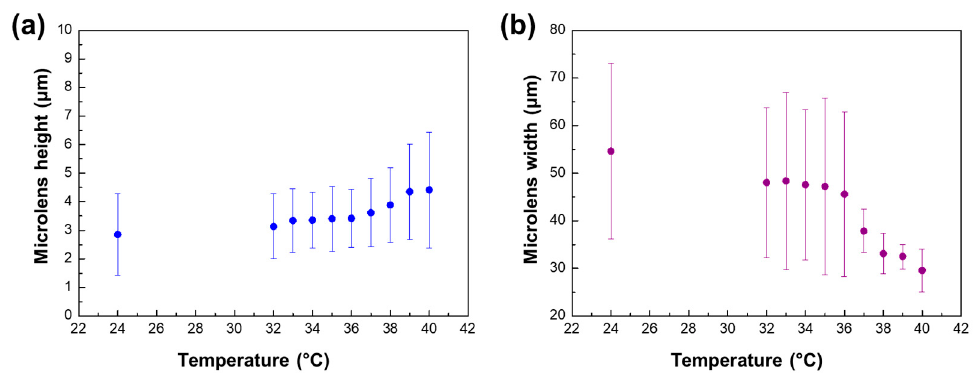
Figure 8. Surface topographical characteristics of the microlens array with a change in ( a ) height and ( b ) width at various temperatures.